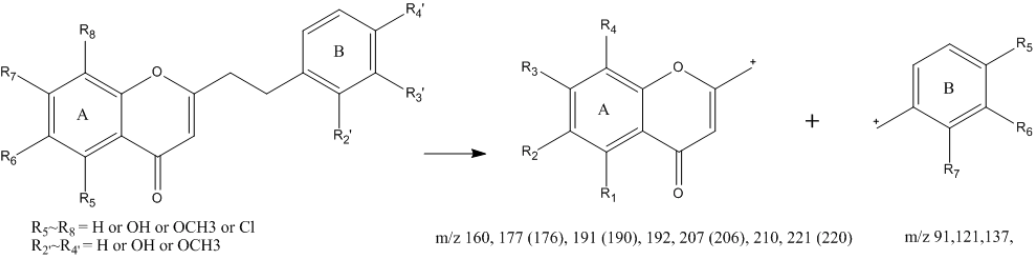
Figure 1. Characteristic fragments of 2-(2-phenylethyl)chromones.